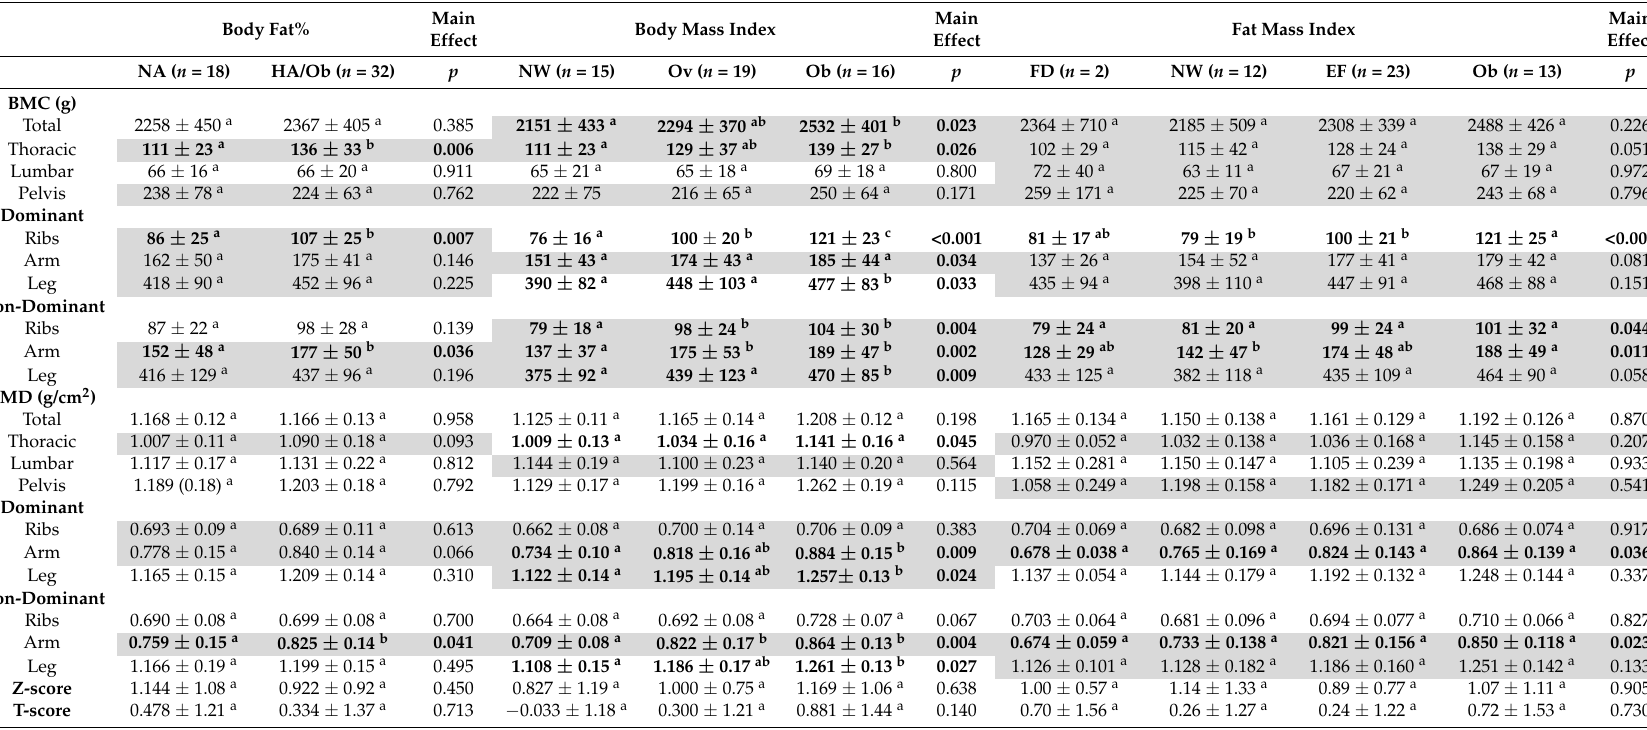
Table A3. Bone mineral content (BMC) and bone mineral density (BMD) characteristics in 50 randomly selected untrained 43–80-year-old adults categorized by body fat%, body mass index (BMI) and fat mass index (FMI)